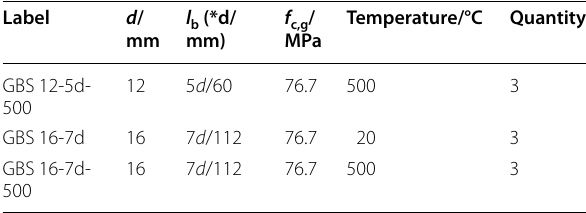
Table 1 Design of the specimens.